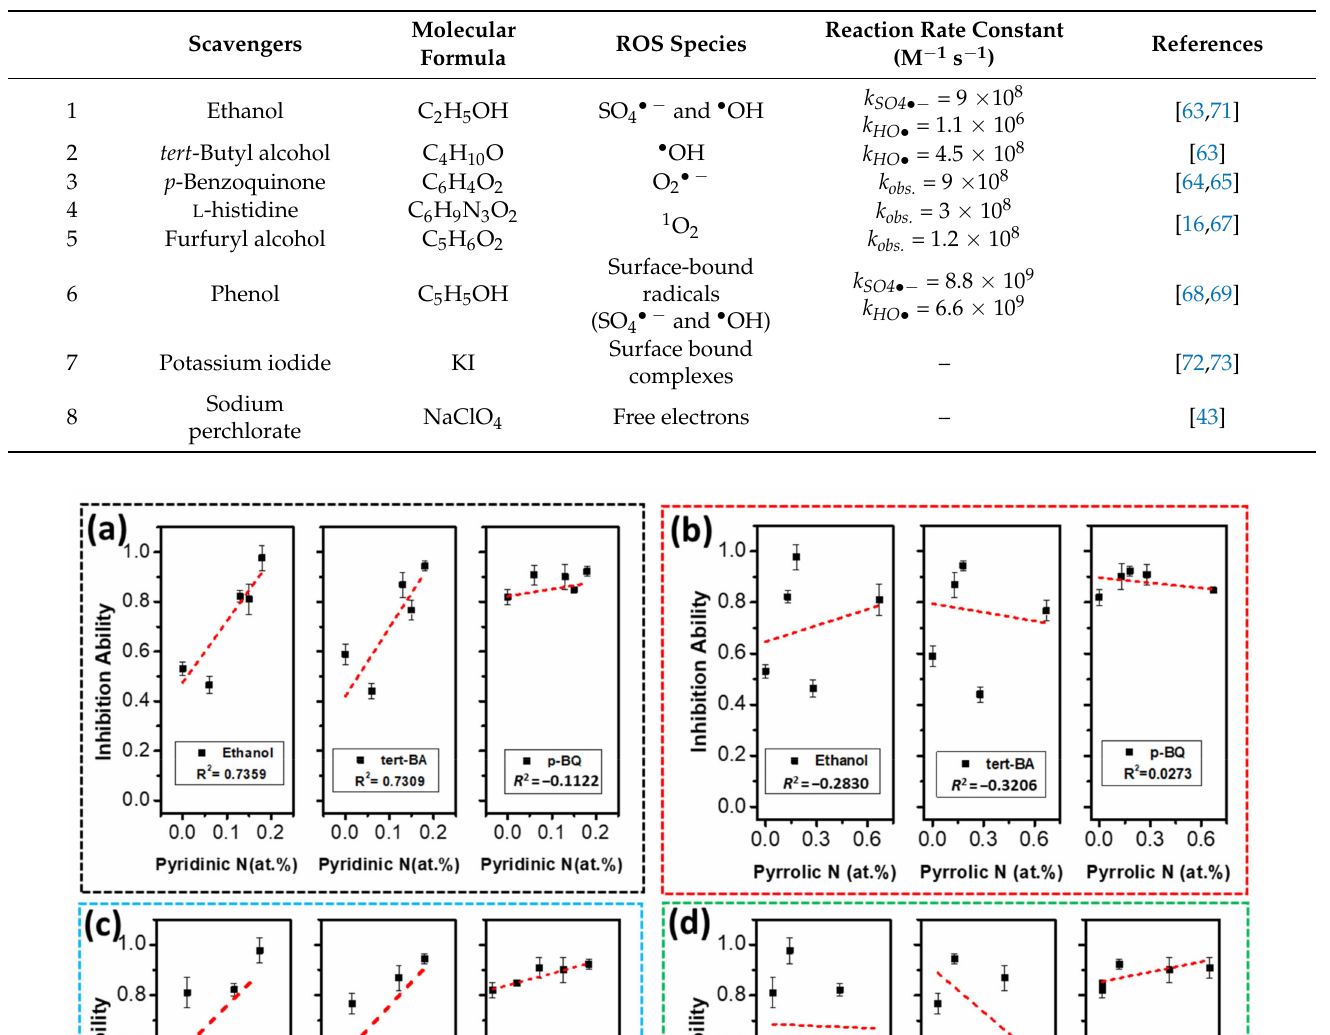
Table 2. The second-order rate constants for the reaction between reactive oxidative species and specific quenchers.